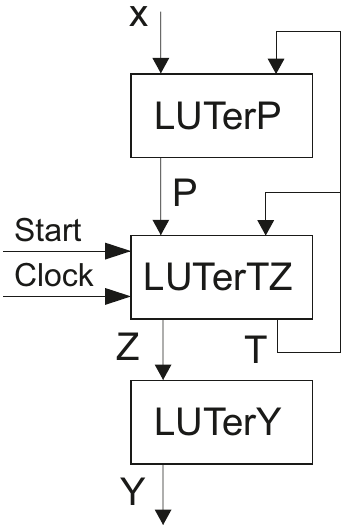
Figure 3. Structural diagram of LUT-based MPY Mealy